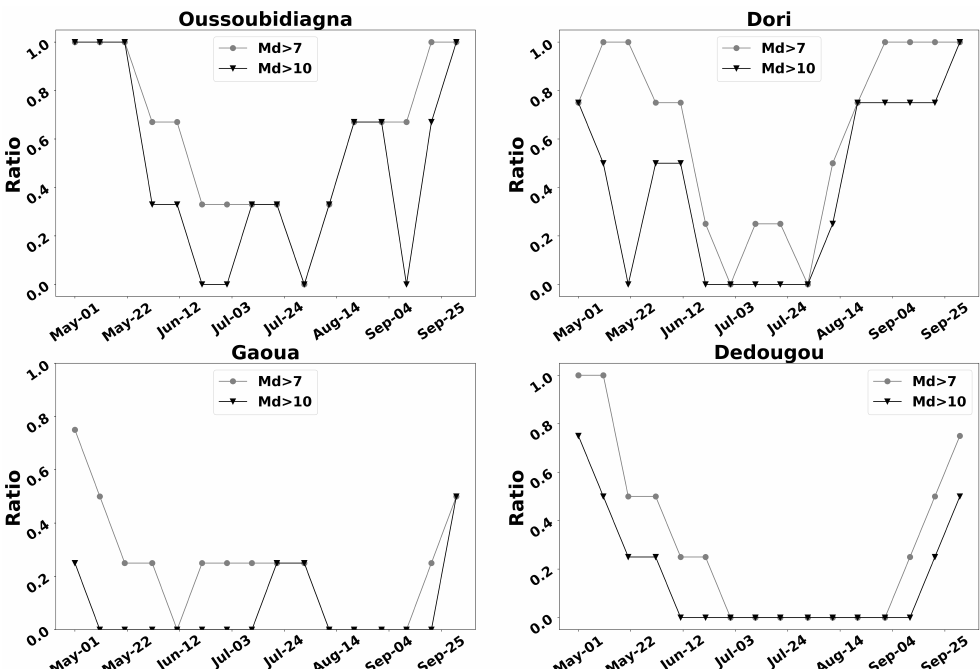
Figure 3. Ratio of maximum dry spells (Md) exceeding 7 and 10 days within 30 days after a specific date at four selected locations. The ratio is defined as the number of years a maximum dry spell occurs over the three-year data period per location, following